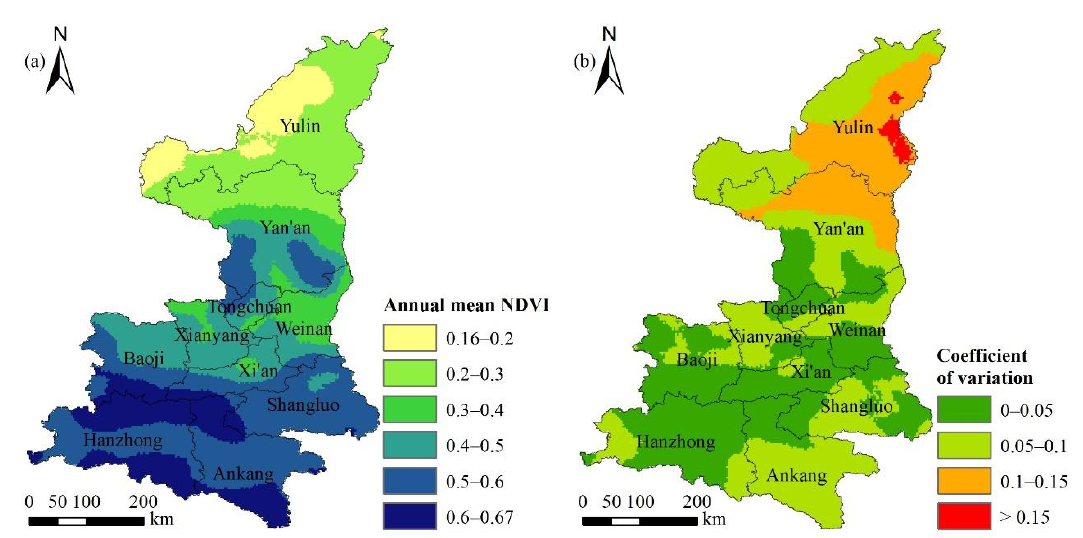
Figure 5. The annual metrics of vegetation phenology( a ) and the season (max NDVI and time integrated NDVI) time series ( b ) (“sos” denotes start of season, “eos” denotes end of season, “Max_NDVI” represents max NDVI, “TI_NDVI” represents time integrated NDVI).